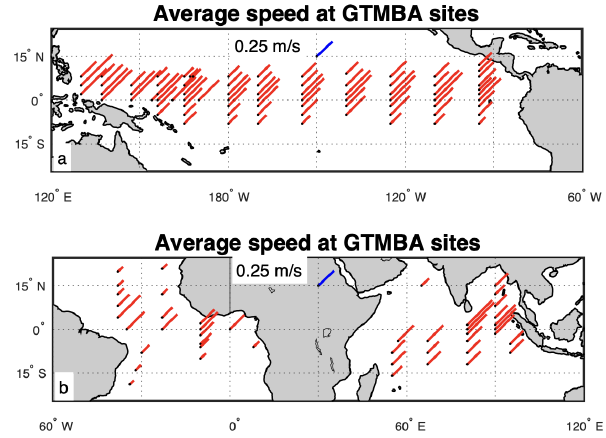
Figure 1. The small black dots represent GTMBA mooring loca- tions. The red lines represent the mean OSCAR current speed over the 1992–2020 time period at each mooring location. Line lengths indicate the average speed, with a scale in blue (top center). The length of the scale corresponds to 25cms − 1 . At that speed, it takes 4.6d to travel 100km. Thus, the line length also corresponds to the time span used in the computation of short-term variability dis- cussed in the text. A shorter line (slower speed) means a longer time span. The directions of the lines have no meaning. Panel (a) shows the Pacific Basin, and panel (b) shows the Atlantic and In- dian